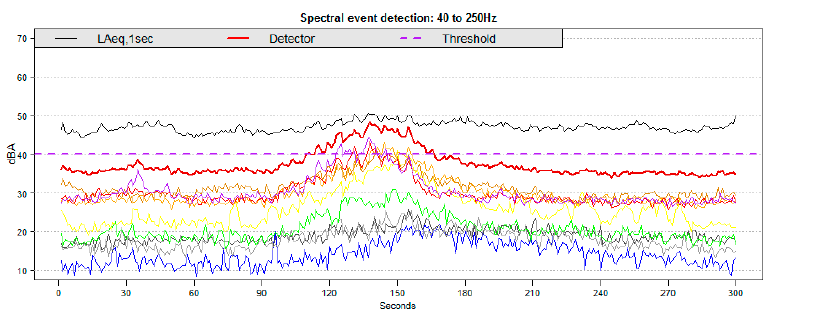
Figure 4. Three time series of a events with L Amax below 50 dBA at ambient levels of 45–48 dBA.